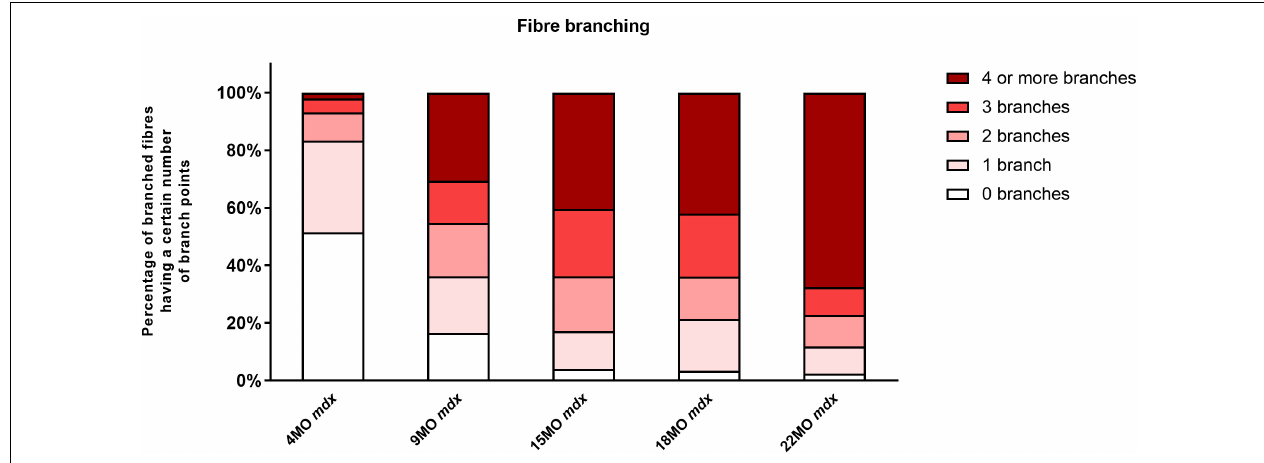
FIGURE 1 | The degree of fiber branching in extensor digitorum longus (EDL) muscles as a percentage of all fibers by categorizing them based on number of branch points. Fibers from littermate controls were omitted due to very low presence of fiber branching, particularly, less than 1%. Note this is a bar graph of all fibers counted and as such is an absolute measure, all photomicrographs in Figures 9 – 11 were taken from these fiber counts. A total of 11,657 fibers from 65 EDL muscles were counted: 7,119 fibers from 34 controls, and 4,538 fibers from 31 mdx muscles. For the 4-month group: n = 1,514 control n = 1,030 mdx fibers; 9-month group: n = 1,320 control n = 1,130 mdx fibers; 15-month group: n = 1,615 control n = 1,263 mdx fibers; 18-month group: n = 1,435 control n = 605 mdx fibers; and 22 month group: n = 1,235 control n = 511 mdx fibers.